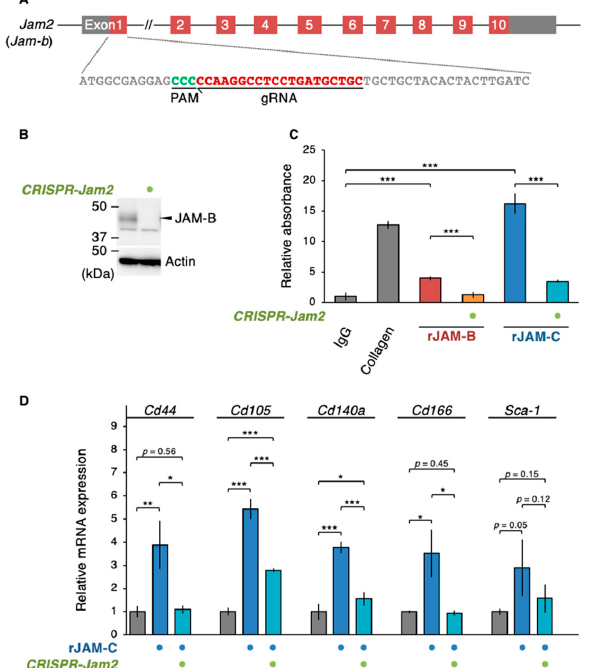
Figure 7. A Soluble JAM-C couples with JAM-B to promote the ADSC adhesion and niche function. ( A ) Knockdown of the Jam2 gene encoding mouse JAM-B in ADSCs using the CRISPR method. ( B ) Western blot for the indicated proteins in the whole-cell lysates of the revealed ADSCs. ( C ) Cell adhesion assay for ADSCs grown in the indicated culture conditions. The relative levels are shown in histograms (mean ± SD; n = 8). ( D ) RT-qPCR for the indicated MSC markers in ADSCs cultivated in the indicated culture conditions. The relative expression levels are shown in the histograms (mean ± SD; n = 4). * p < 0.05; ** p < 0.01; *** p <